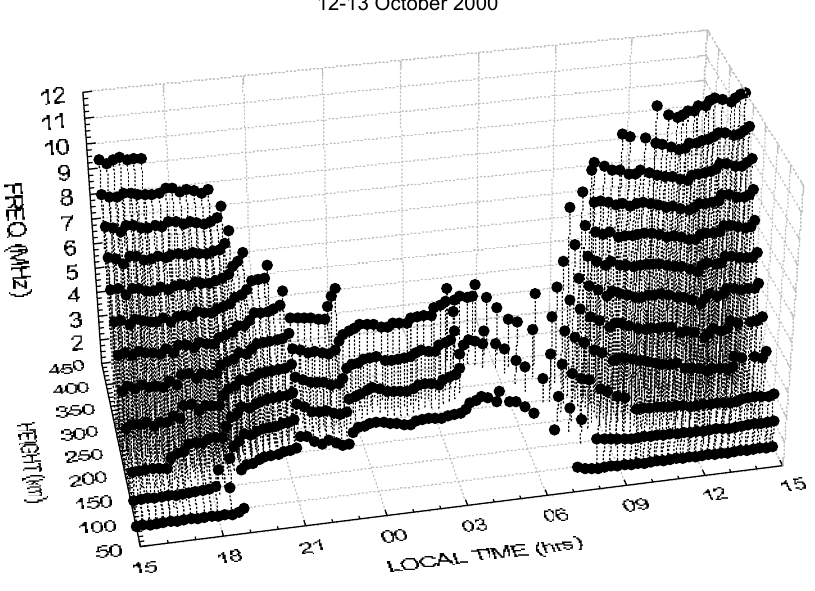
Fig. 8. The 3-D plot of the height vari- ation for plasma frequencies 2–12MHz versus the local time for the night hours between 12 and 13 October 2000. Ion- isation enhancement was observed over